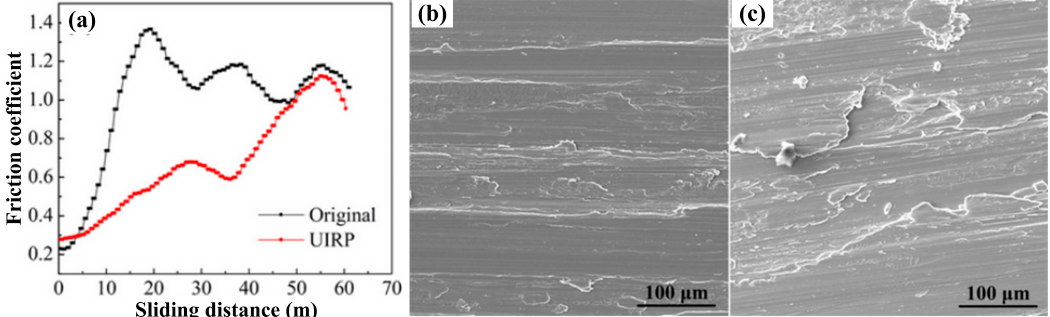
Figure 10. Friction coefficients and worn morphologies obtained at 637 r/min after 300 cycles. ( a ) Friction coefficients; ( b ) worn morphology of UIRP sample; ( c ) worn morphology of the original sample.